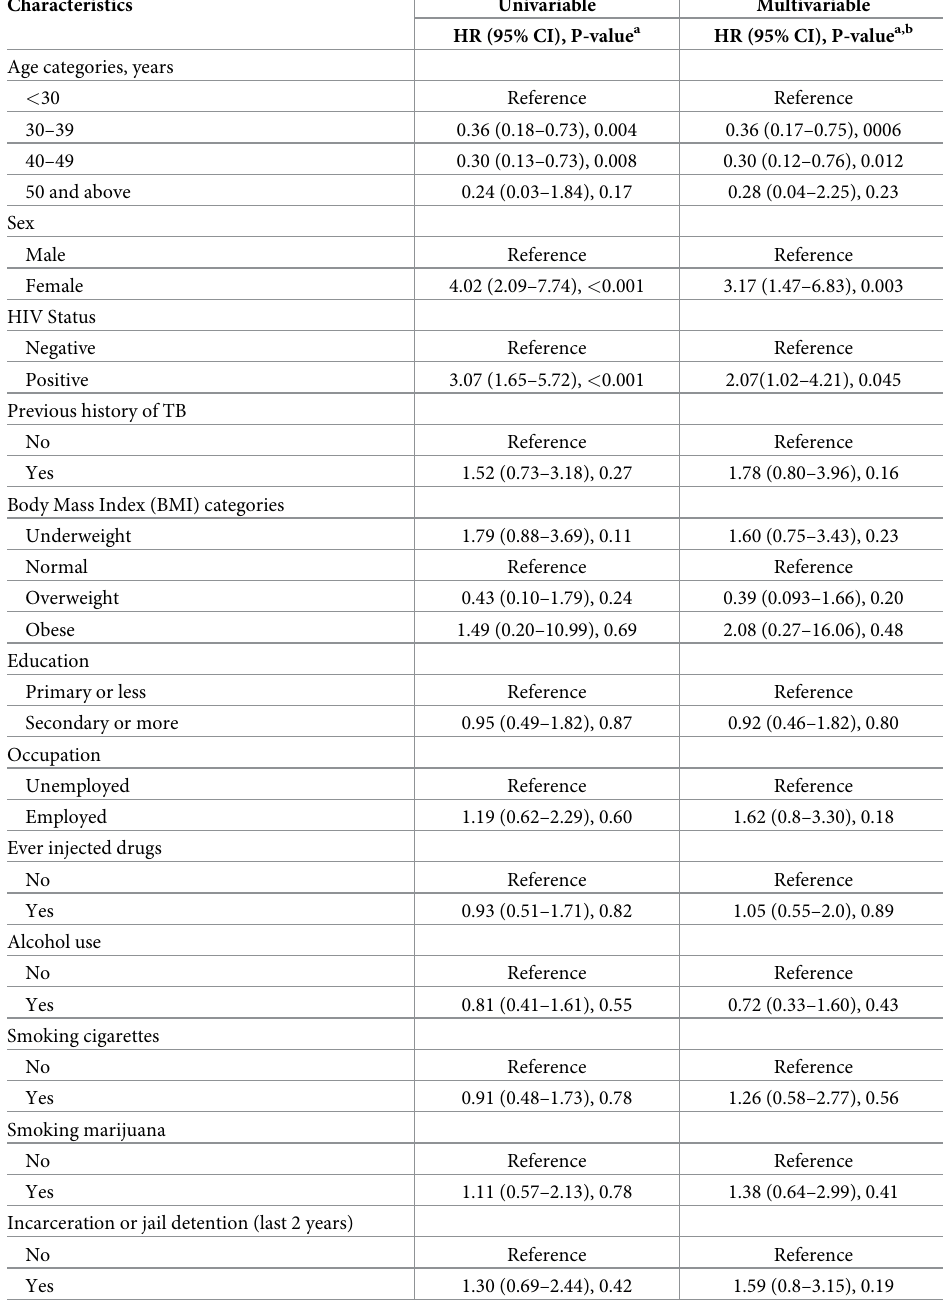
Table 2. Risk factors of incident TB disease among people receiving medication-assisted treatment for substance use disorder in Dar es Salaam, Tanzania (n = 823, incident TB disease =